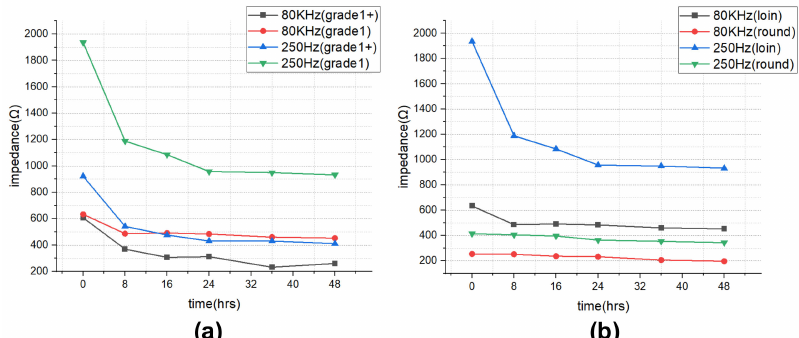
Figure 6. Impedance over the storage periods showing differences between ( a ) quality grade 1+ and 1, and ( b ) loin and round.